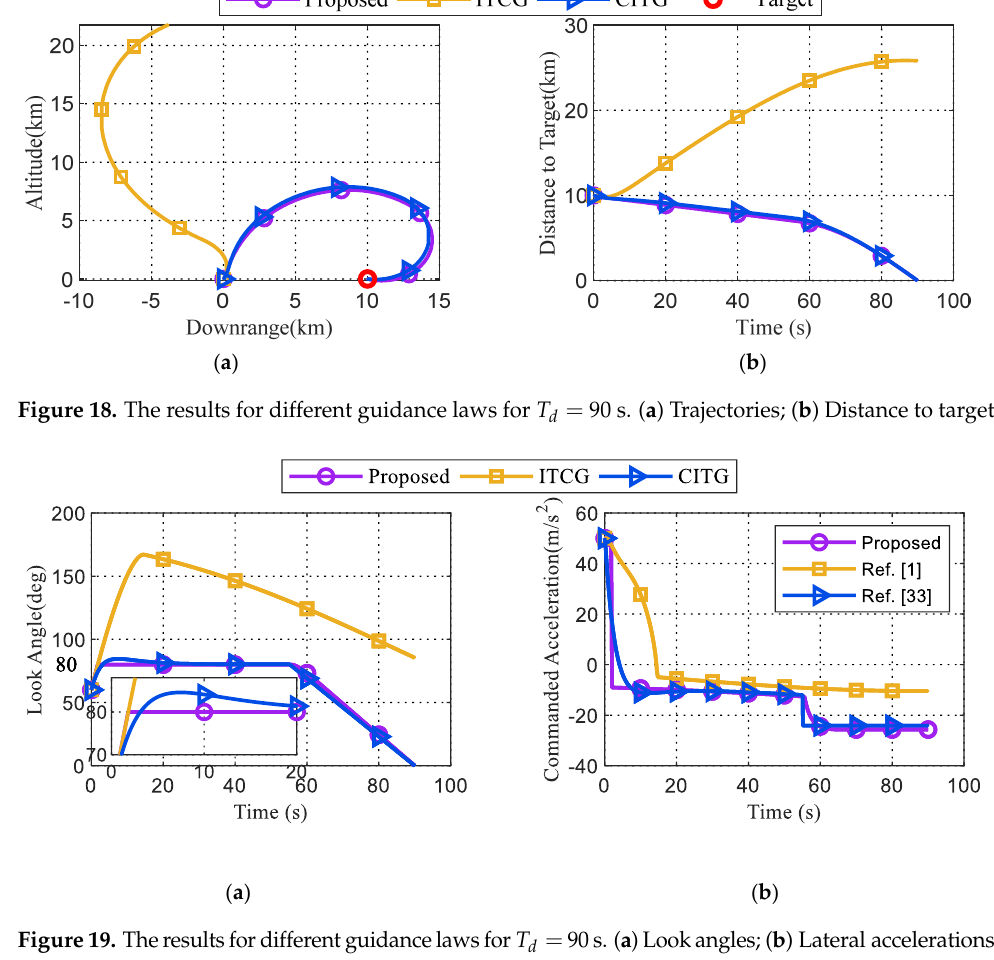
Figure 19. The results for different guidance laws for d ations.